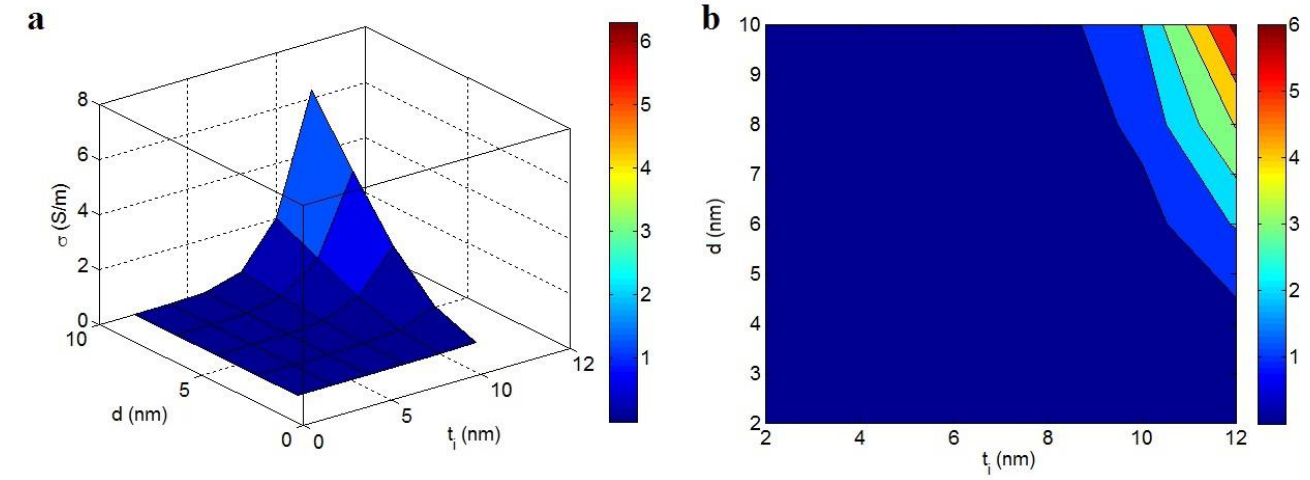
Figure 6. Impact of “t i ” and “d” on the nanocomposite’s conductivity using ( a ) 3D and ( b ) 2D designs.